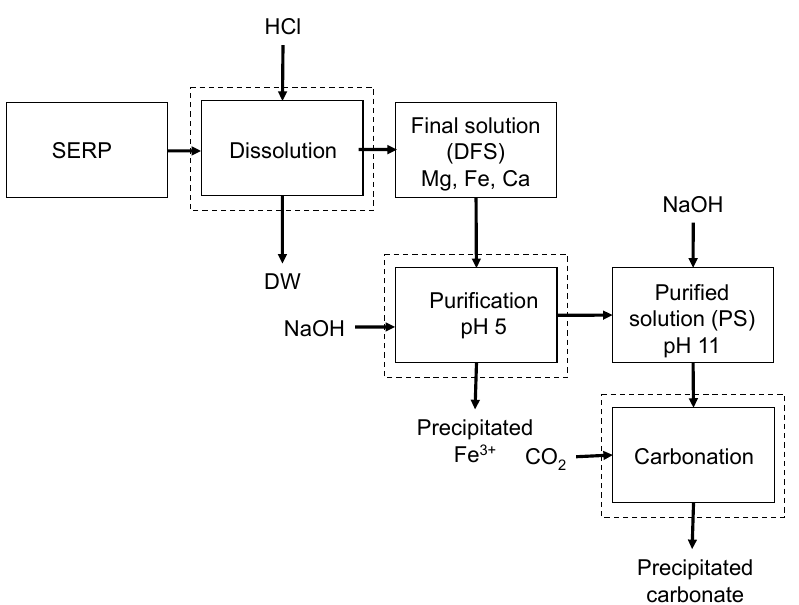
Figure 2. Simplified flowchart of CO 2 sequestration by pH-swing mineral carbonation.